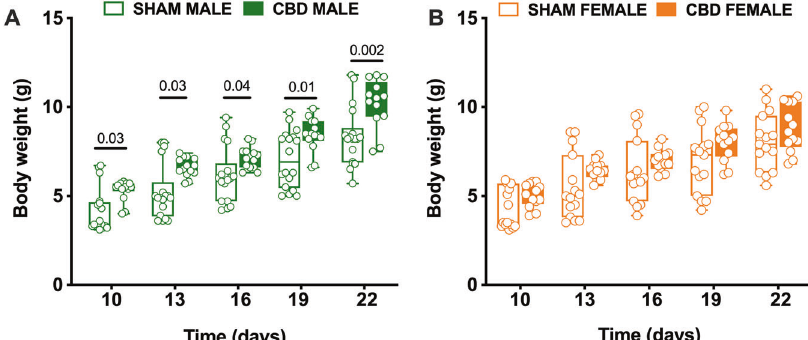
Fig. 1 Prenatal exposure to CBD speci fi cally increases the body weight of male offspring. A , B Starting at PND 10, SHAM and CBD pups of both sexes were weighed every 3 days until one day after weaning (i.e., [22]). Fetal CBD exposure was associated to increase of bodyweight in male ( A ) but not female progeny ( B ), (SHAM MALE N = 18 light green, CBD MALE N = 14 dark green, SHAM FEMALE N = 14 light orange, CBD FEMALE N = 12 dark orange). Data are represented as Box and whisker plots ( fi rst quartile, median, third quartile). Individual data point represents a single animal. Multiple Mann – Whitney U